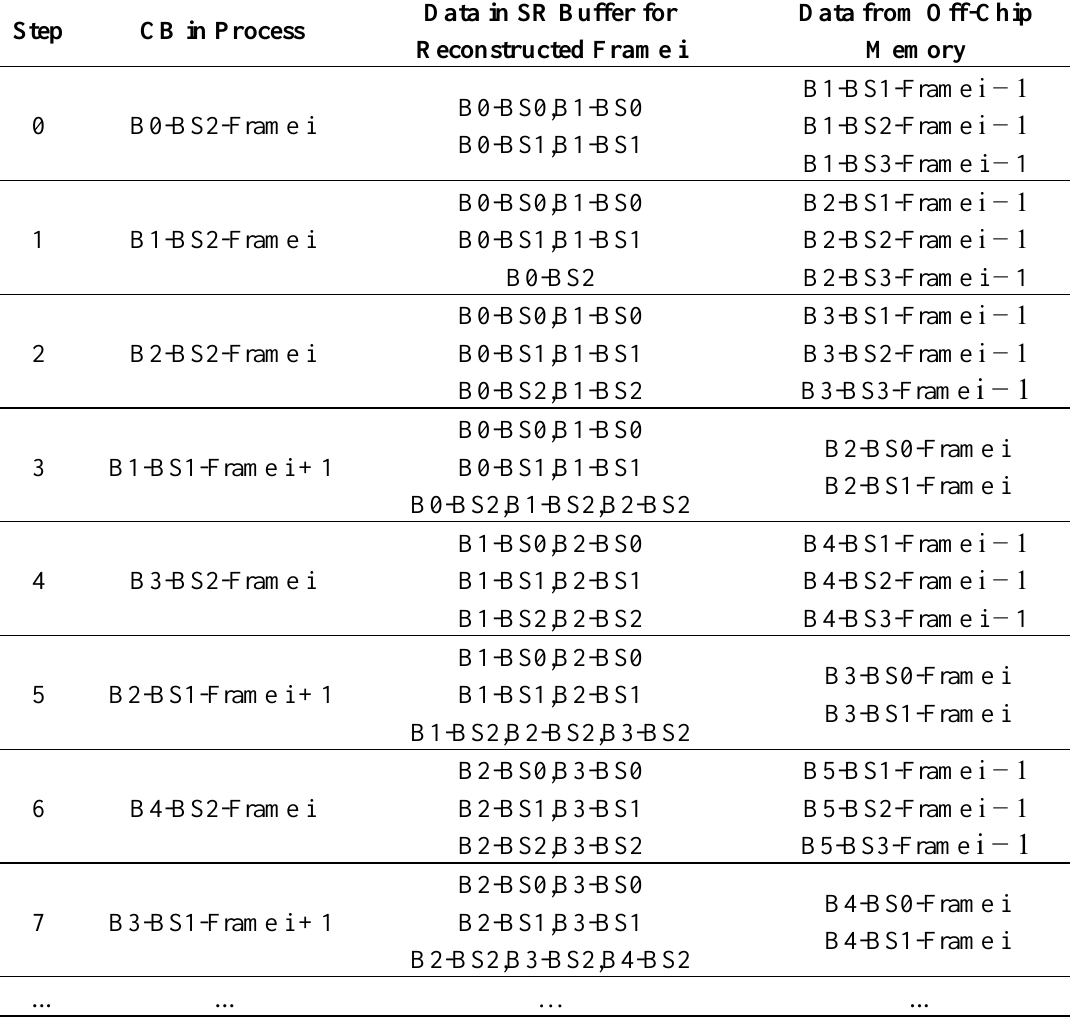
Figure 15. The order of the CBs in process for Inter-C of